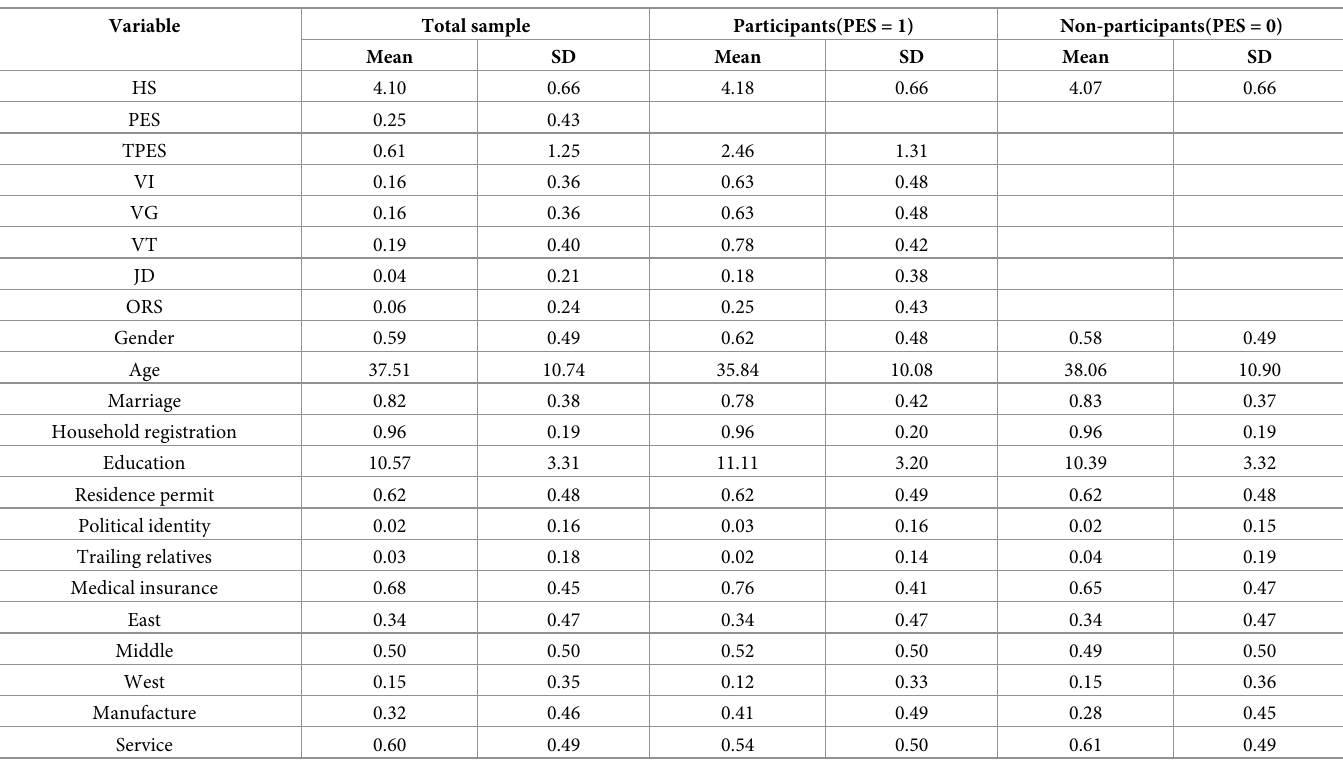
Table 1. Descriptive statistics of the main variables.